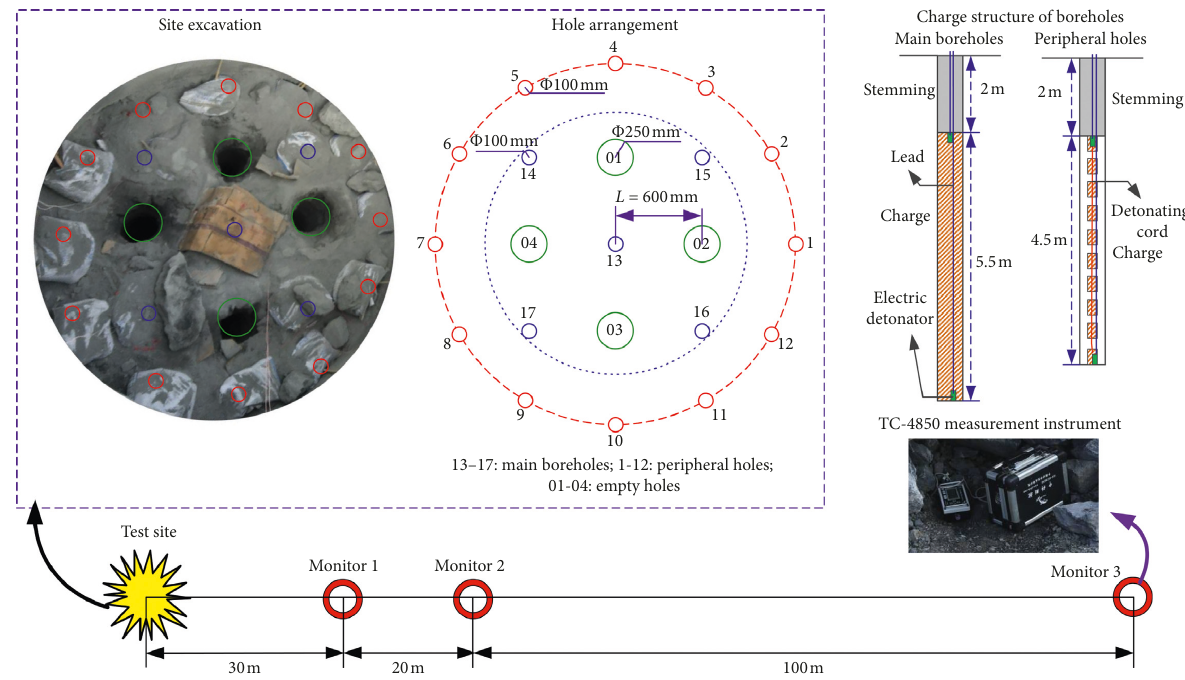
Figure 3: Schemes of blast implementation and vibration measurement for two field experiments.